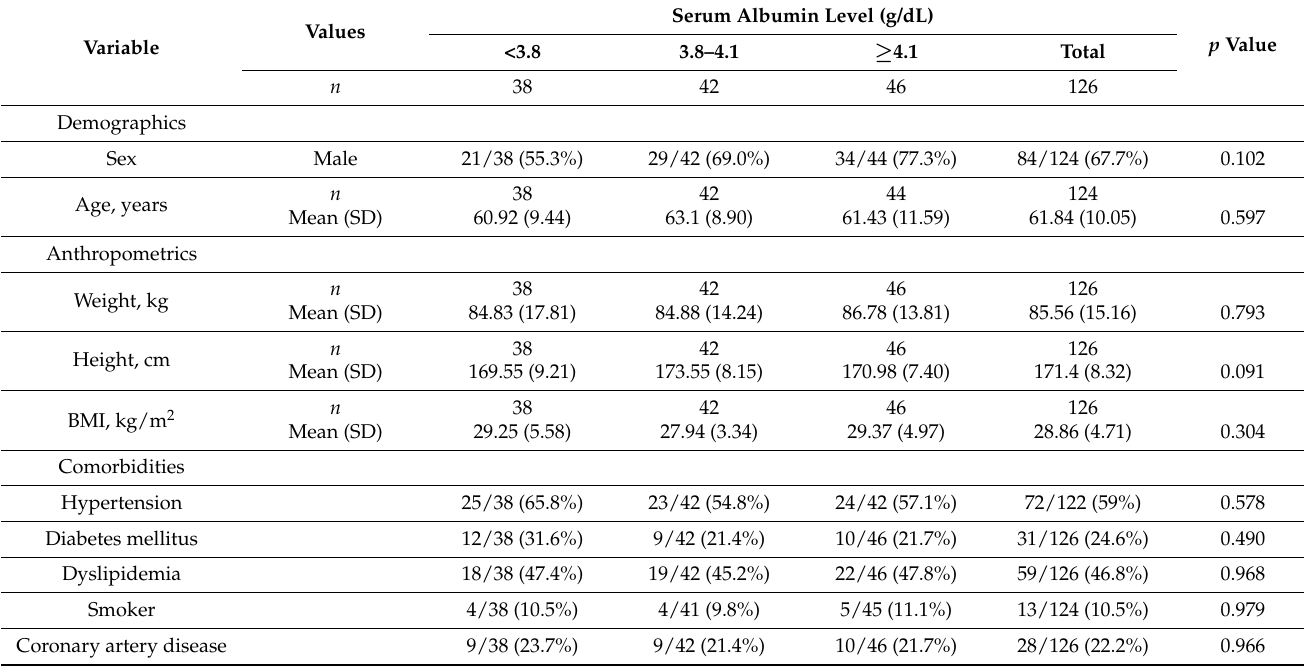
Table 1. Baseline characteristics (demographics and comorbidities) according to serum albumin (SA) level